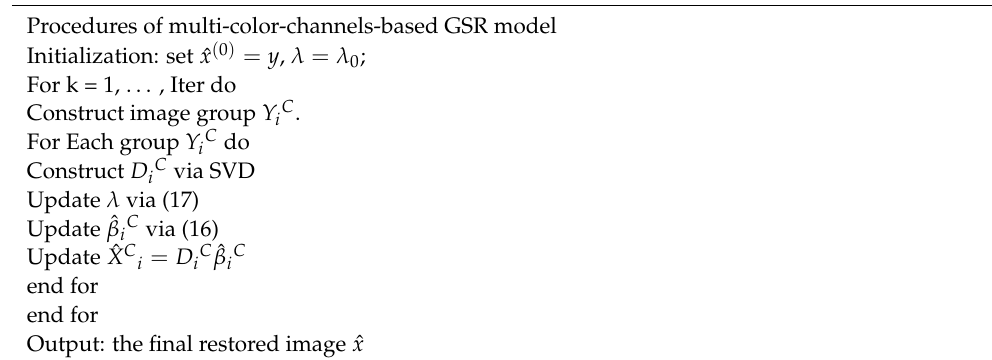
Algorithm 1 The proposed multi-color-channels-based GSR model Procedures of multi-color-channels-based GSR